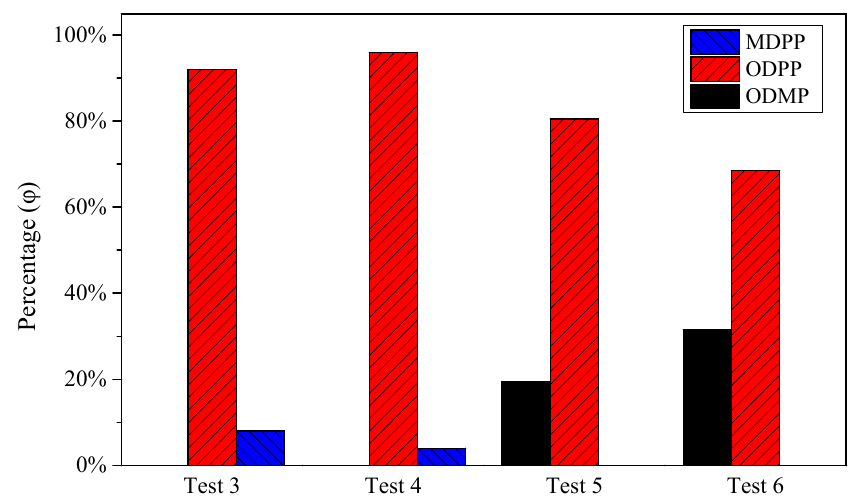
Figure 12. The statistical data of the three types of projected transfer.